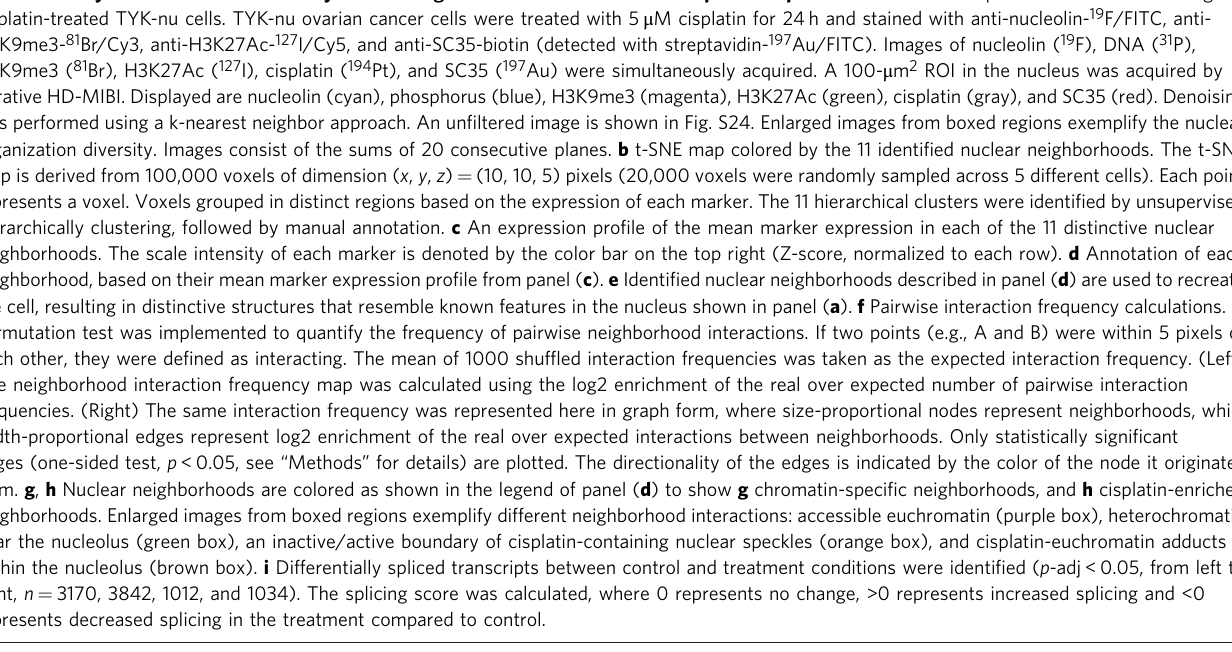
Fig. 5 An analytical framework to identify nuclear neighborhood interactions in multiplexed super-resolved data. a Representative HD-MIBI image of cisplatin-treated TYK-nu cells. TYK-nu ovarian cancer cells were treated with 5 μ M cisplatin for 24 h and stained with anti-nucleolin- 19 F/FITC,